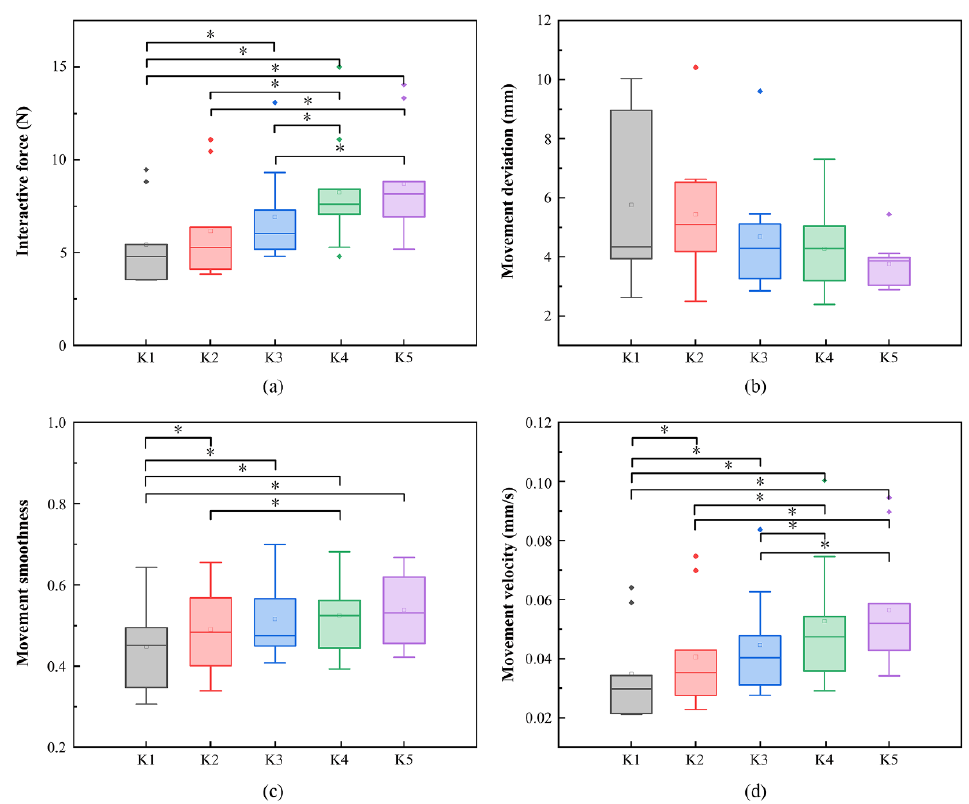
Figure 8. The characteristic parameters of movement in five different stiffness parameters: ( a ) interactive force of patients in five different stiffness parameters; ( b ) movement deviation of patients in five different stiffness parameters; ( c ) movement smoothness of patients in five different stiffness parameters; ( d ) movement velocity of patients in five different stiffness parameters. * p < 0.05.